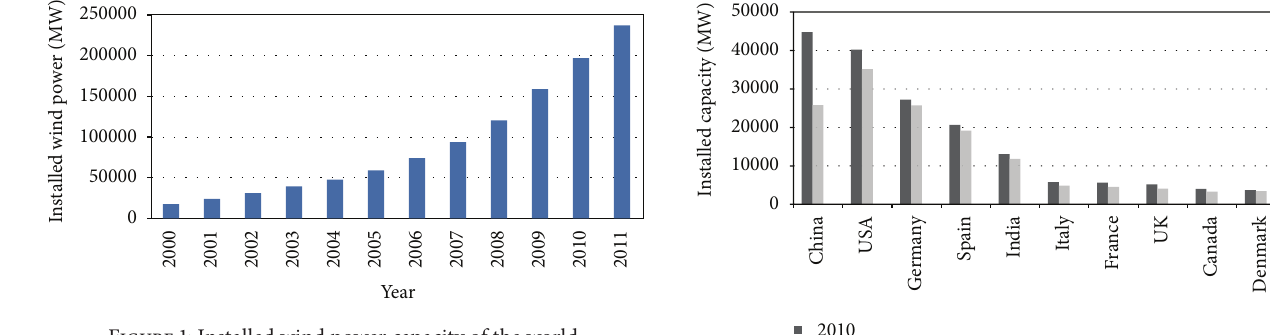
Figure 1: Installed wind power capacity of the world.